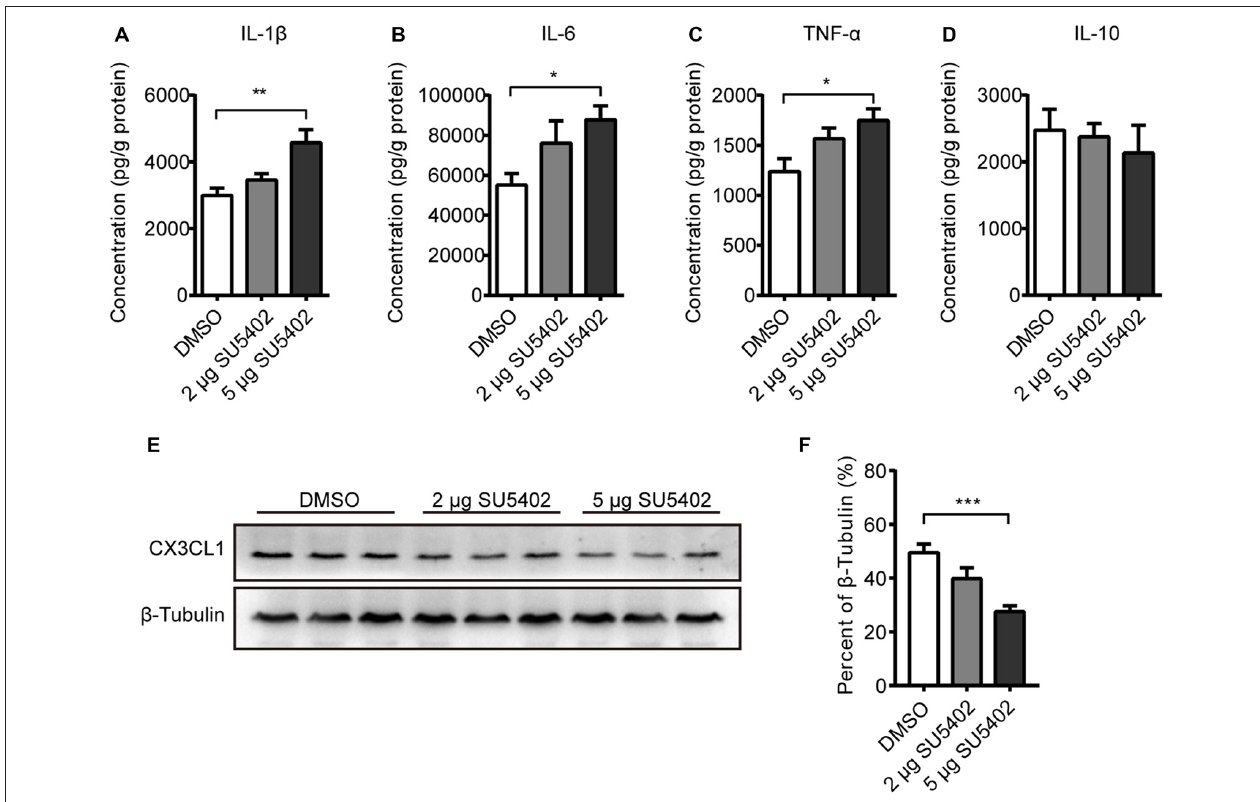
FIGURE 6 | Impact of FGFR inhibitor (SU5402) on cytokines and CX3CL1 expression in hippocampus. (A–C) The IL-1 β , IL-6 and TNF- α levels were increased by 5 µ g dose of SU5402. (D) SU5402 did not influenced the IL-10 level. (E) Representative western blots of CX3CL1 and corresponding normalized control β -Tubulin in hippocampus. (F) The expression of CX3CL1 was decreased by 5 µ g dose of SU5402 infusions. One-way ANOVA with Dunnett’s multiple comparisons test, n = 5 or 6 per group. Data are presented as the means ± SEM. ∗ p < 0.05, ∗∗ p < 0.01; ∗∗∗ p < 0.001. DMSO, dimethyl